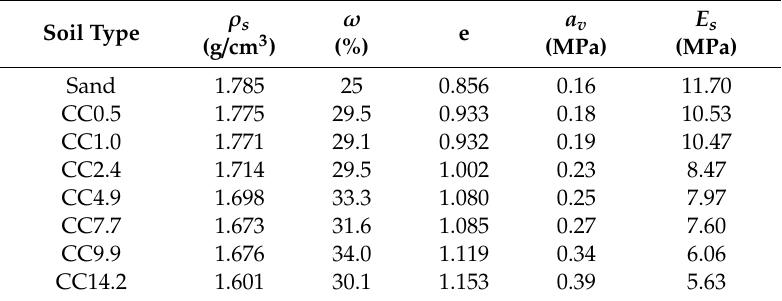
Table 2. Compression modulus of soil